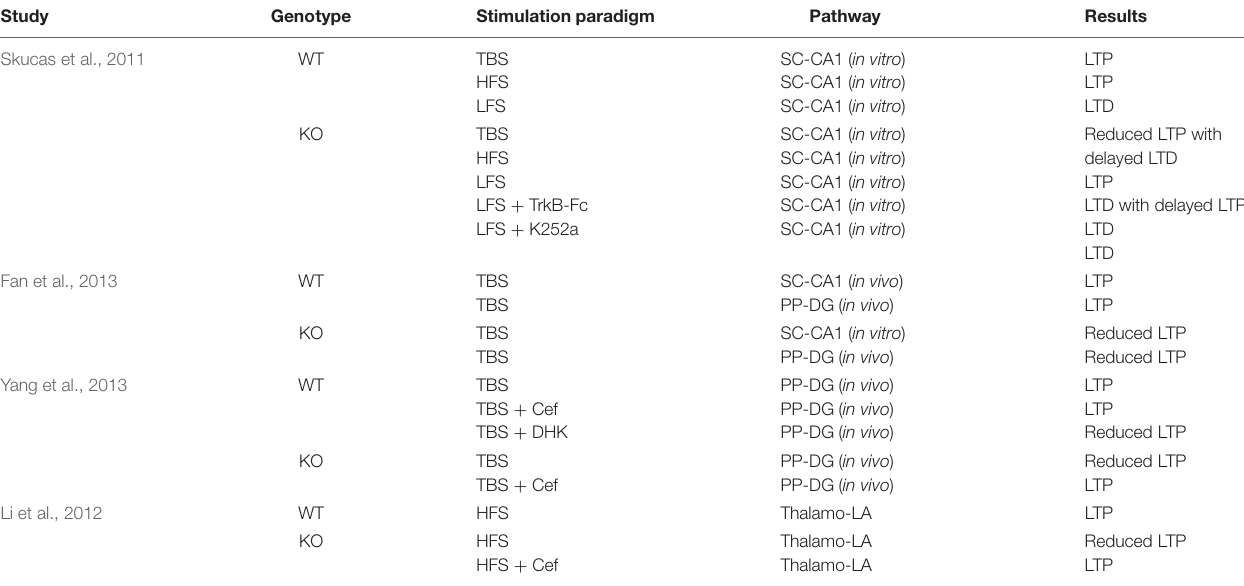
TABLE 1 | AQP4 in synaptic